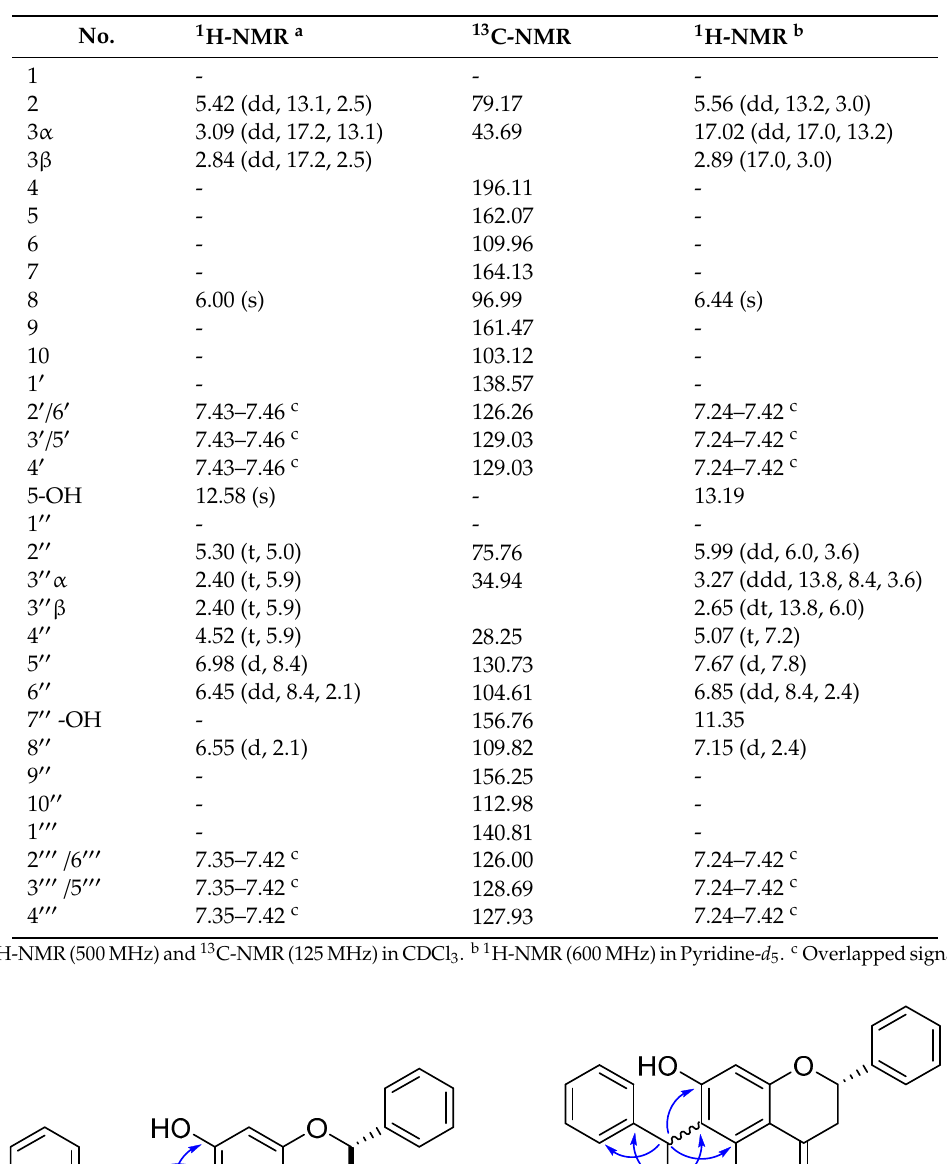
Table 1. 1 H-NMR and 13 C-NMR data for oxytrodiflavanone A ( 1 ) ( δ in ppm, J in Hz).